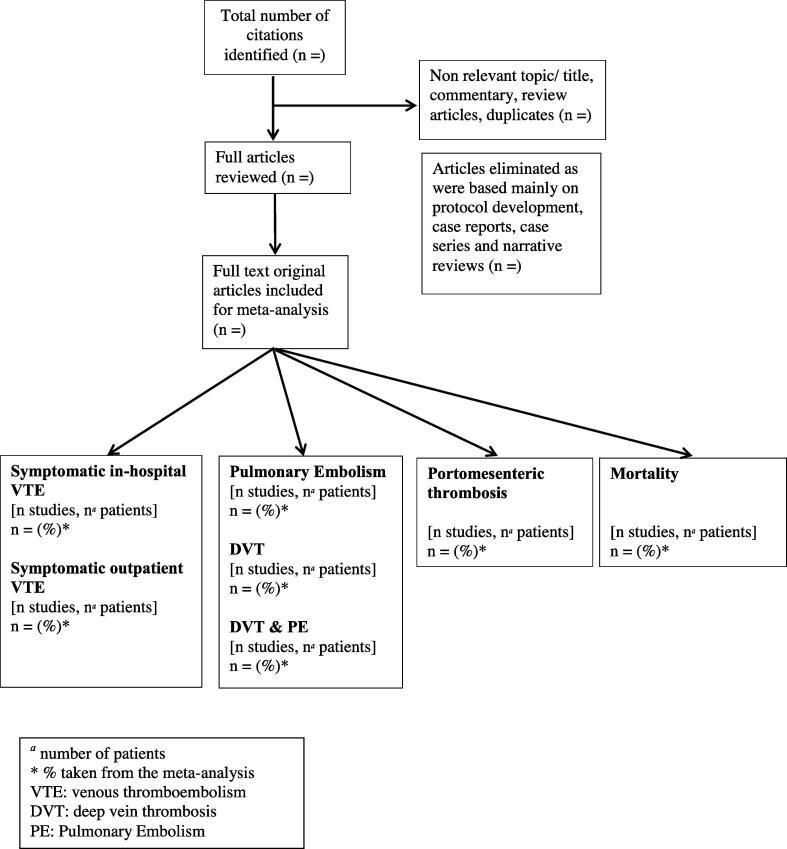
Flow diagram of study selection process for the systematic review.